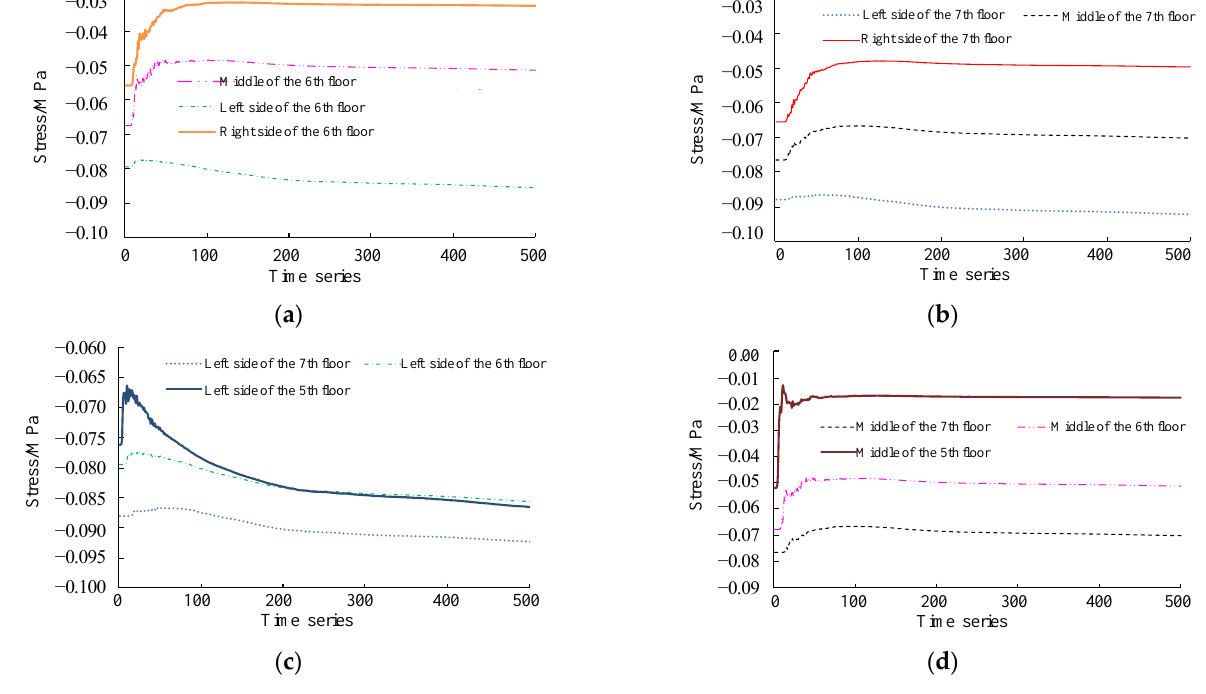
Figure 8. Stress evolution law after excavation in different layers. ( a ) 6th layer base plate stress; ( b ) 7th layer base plate stress; ( c ) Left stress of roadway floor; ( d ) The middle stress of roadway floor. From Figure 8a,b, it can be seen that the stress state of the left, middle, and right sides of the same horizontal coal seam floor are not the same; the stress on the left side of the coal seam floor is the largest, followed by the middle of the floor, and the stress on the right side of the floor is at the lowest state. After the excavation of the fifth stratum, the stress in the middle of the bottom plate of the sixth stratum decreases rapidly from − 0.068